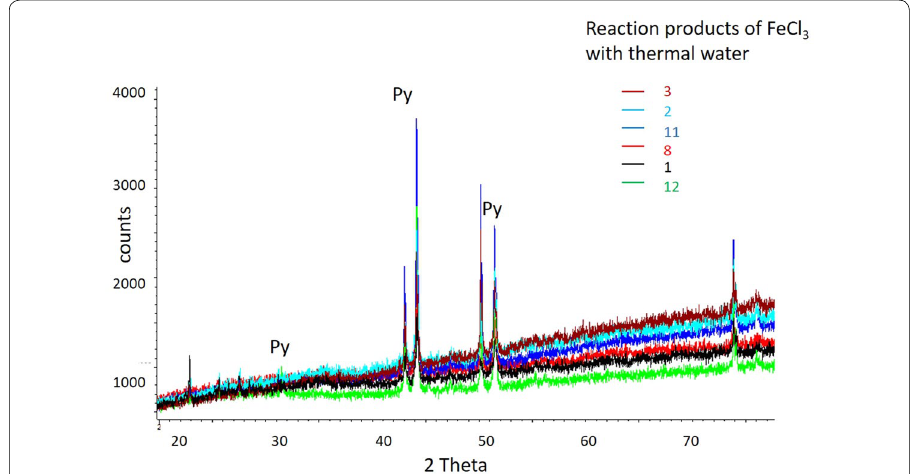
Fig. 9 XRD pattern of iron precipitates collected from the filters. Marked peaks (py) indicate the presence of